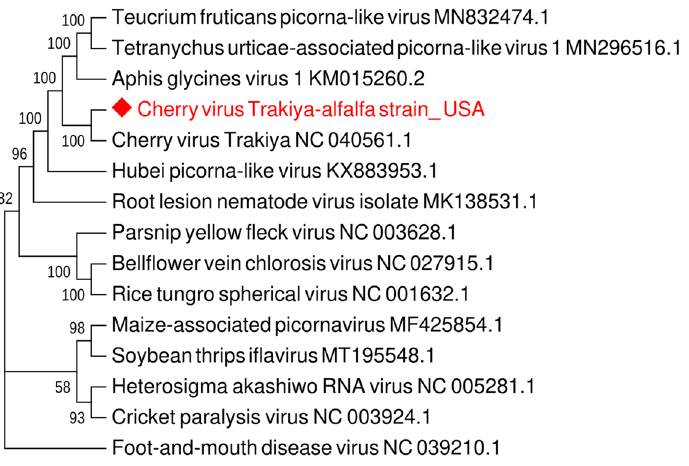
Figure 2. Phylogenetic relationship of cherry virus Trakiya, alfalfa strain, with other species of the order Picornavirales . The tree was deduced from the ClustalW alignment of complete nucleotide sequences and built using MEGA 7 software with Maximum Likelihood method based on the Tamura-Nei model and bootstrap analysis of 1000